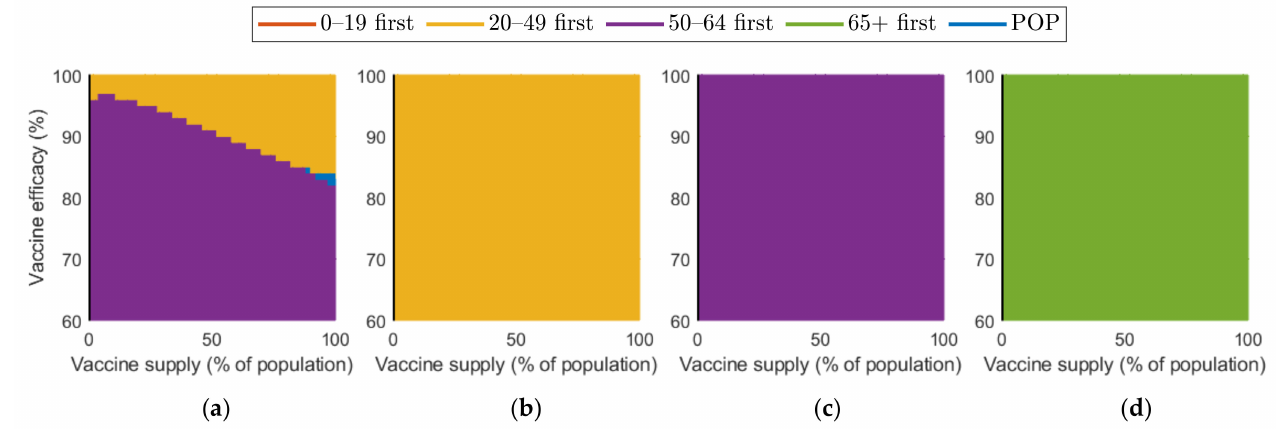
Figure 10. Vaccination priority strategy for the best reduction in cumulative confirmed cases of various vaccination supplies and efficacies under different SD levels: ( a ) 0, ( b ) 1, ( c ) 2, and ( d ) 3.